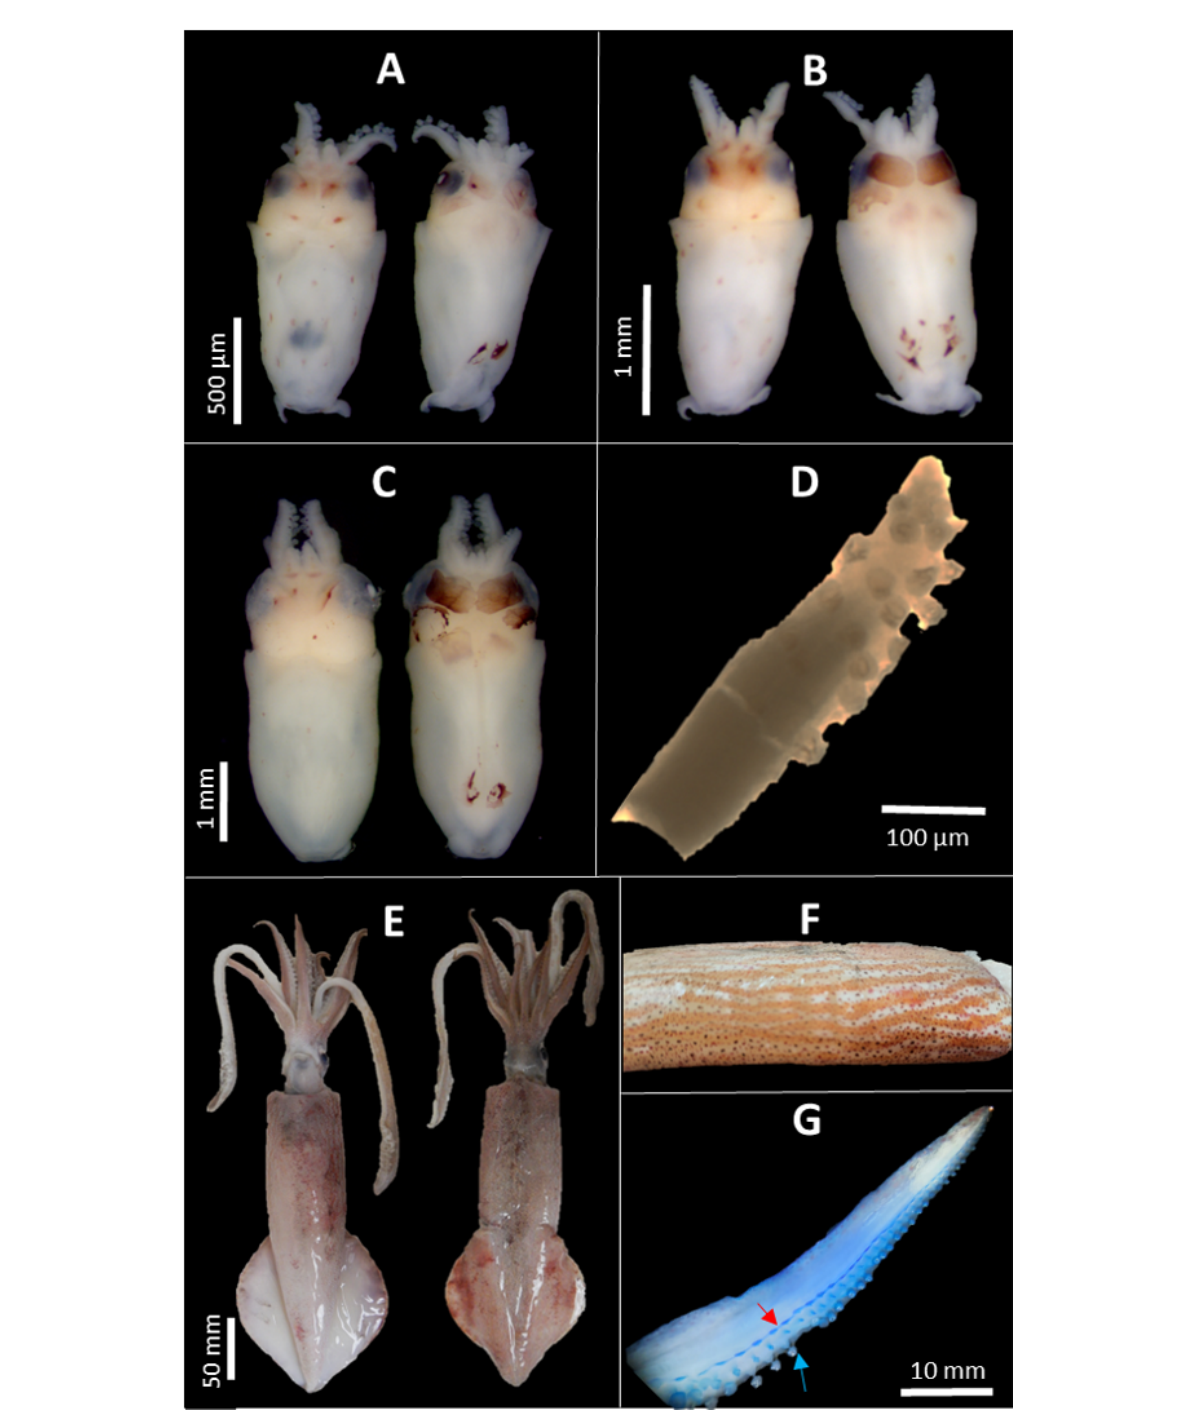
FIGURE 2 Doryteuthis pleii paralarvae collected in the Yucatan Shelf. Ventral and dorsal views of paralarvae of (A) 0.8 mm (B) 1.4 mm, (C) 3 mm of mantle length. (D) Tentacle club with four rows of suckers on manus of a 3 mm paralarvae. (E) Ventral and dorsal (265 mm ML), (F) hectocotylus (red arrow indicating modi fi ed suckers and blue arrow the regular ones) and (G) ventral mantle with the striped pattern along the surface of a male adult from Progreso port of